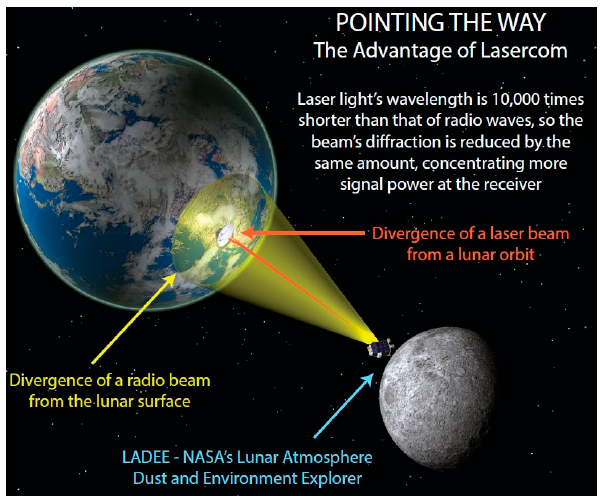
Figure 5. Divergence Examples—Radio and Laser [43].